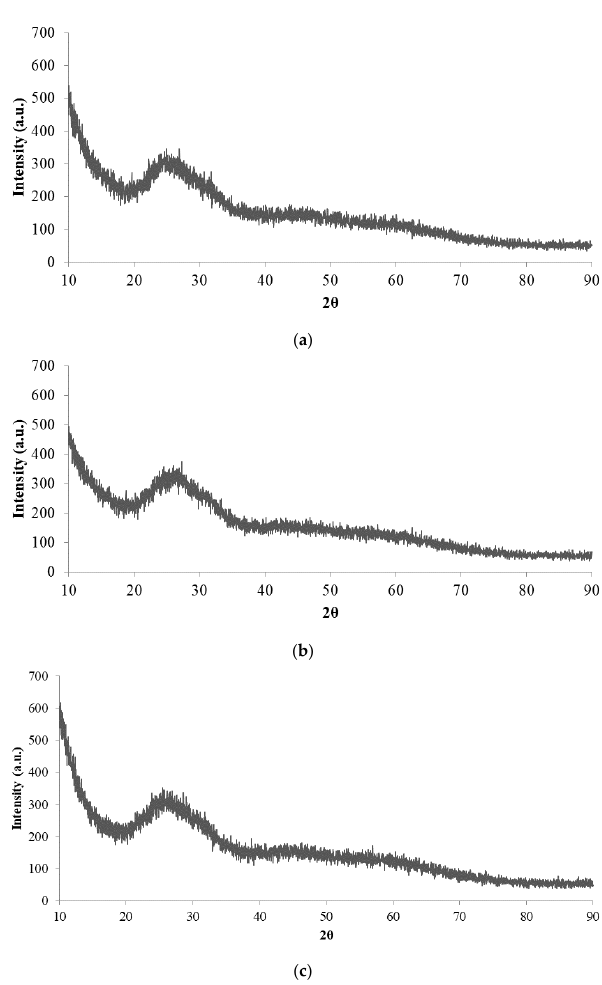
Figure 9. XRD results for ( a ) microwaved, ( b ) refrigerated, and ( c ) sonicated TiO 2 (from top to bot ‐ tom order).